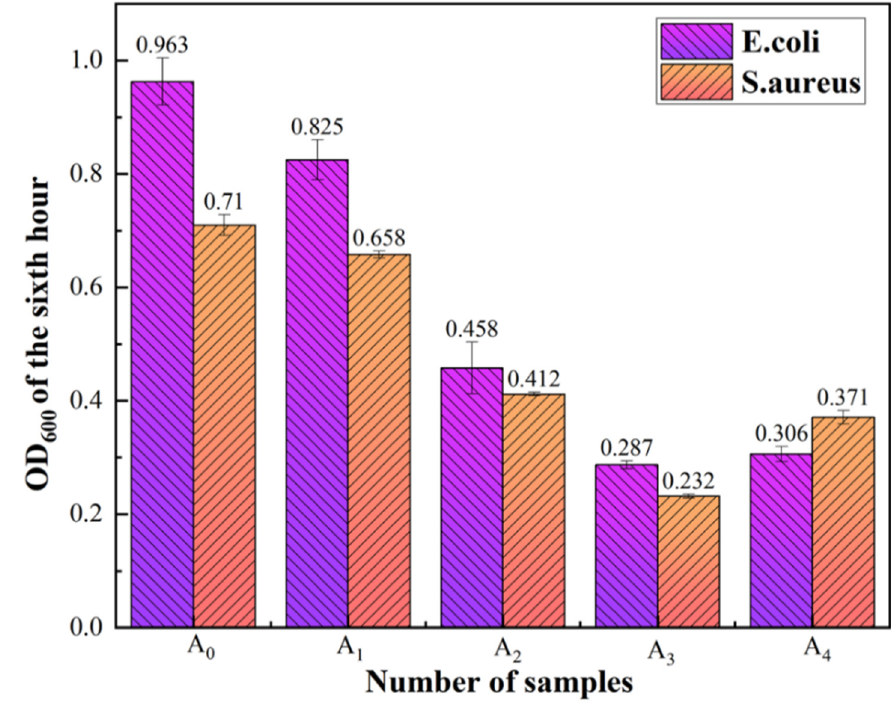
Figure 11. Final optical density for E. coli and S. aureus.